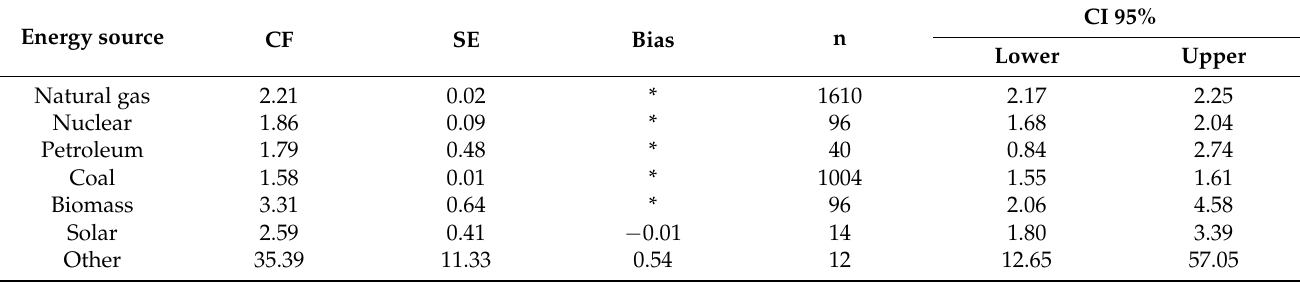
Table 2. Water consumption estimated rates (CF, m 3 /MWh) for various energy sources, standard error (SE), bootstrap bias, sample size (n) and 95% confidence intervals (CI). Other includes blast furnace gas, batteries, hydrogen, purchased steam sulfur, tire-derived fuels and other miscellaneous energy